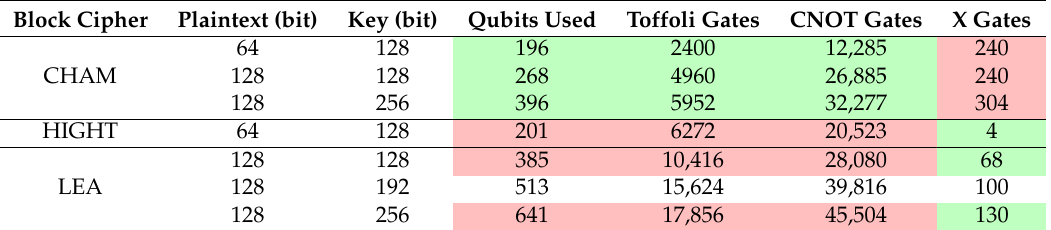
Table 6. Comparison between Korean block ciphers in terms of quantum